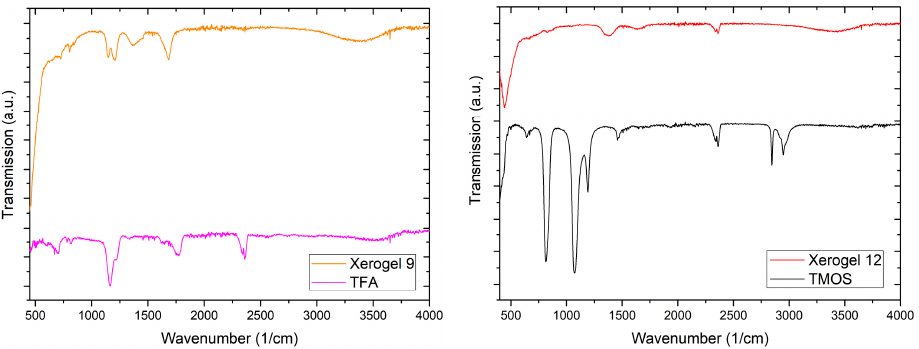
Figure 3. IR spectra of xerogel 9 (orange) and TFA (purple) ( Left ), IR spectra of xerogel 12 and TMOS (black) ( Right ).